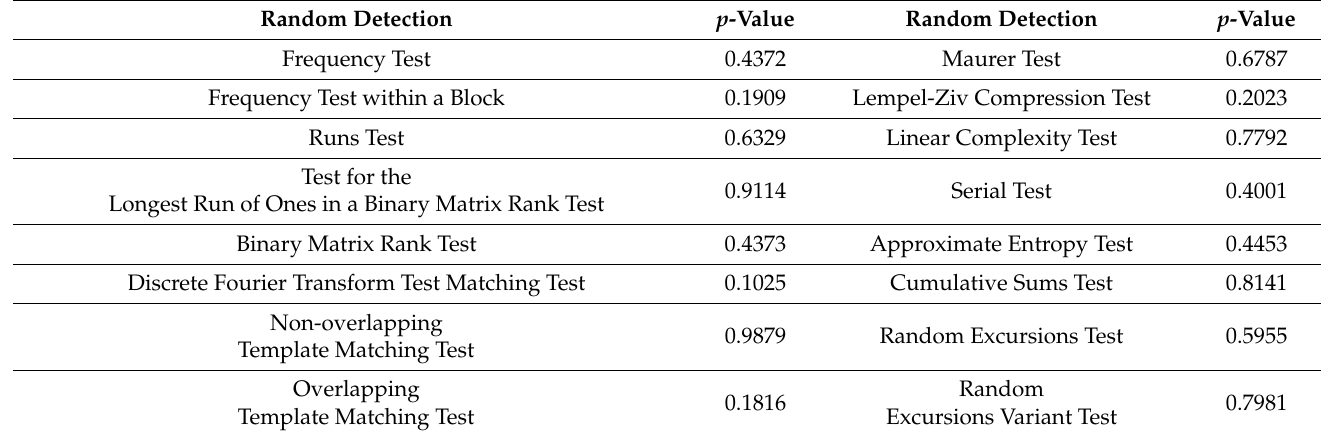
Table 1. National Institute of Standards and Technology (NIST) randomness testing